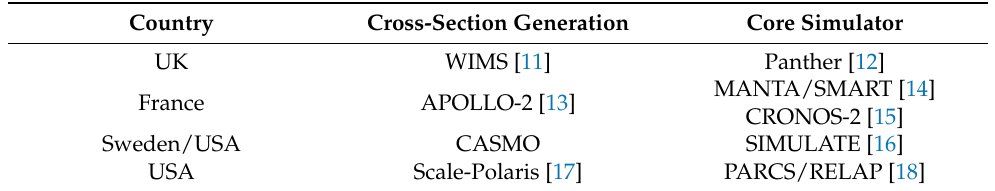
MANTA/SMART [14] CRONOS-2 [15]